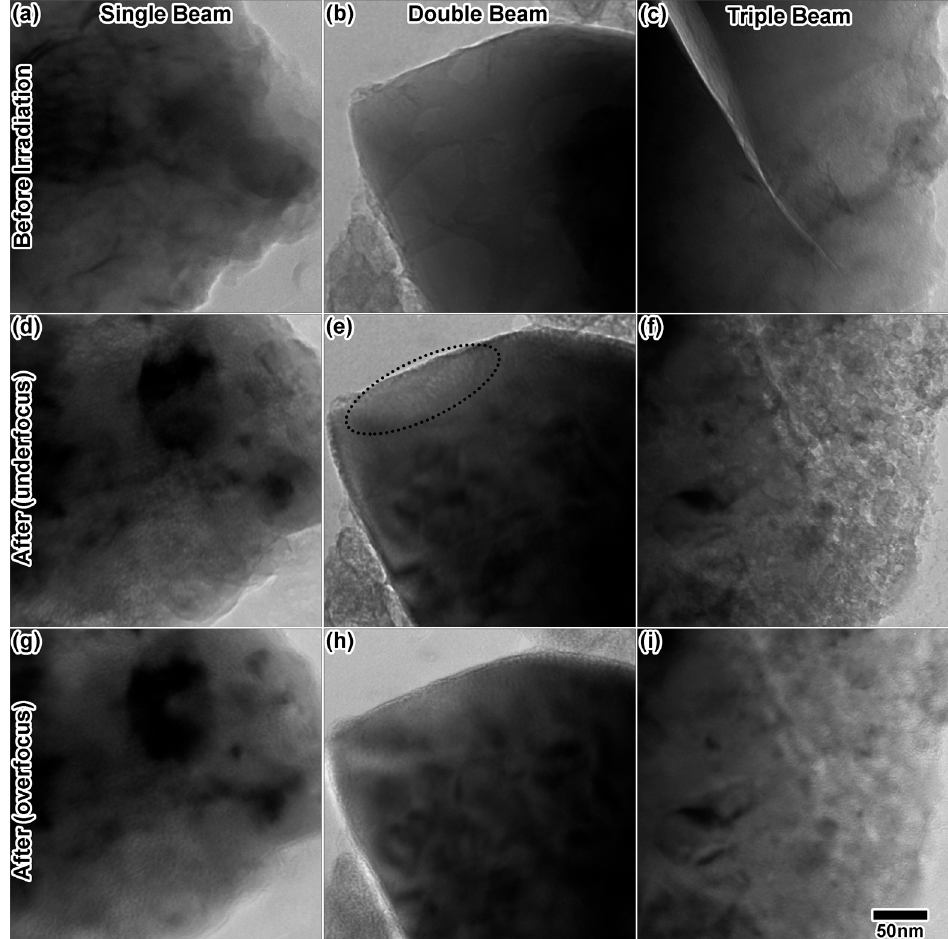
Figure 12. TEM images from before and after single, double and triple ion irradiation at 310 °C in LiAlO 2 . ( a – c ) The particles before irradiation; ( d – f ) The particles in underfocus after irradiation and ( g – i ) the particles in overfocus after irradiation with 10 keV He, 10 keV He + 5 keV D and 10 keV He + 5 keV D + 1.7 MeV Au, respectively. (a,c,d,f) were taken at − 518-nm defocus, and (b,e) were taken at − 1- μ m defocus. (g,i) were taken at +518-nm defocus, and (h) was taken at +1- μ m defocus. The electron beam was on during the single and triple ion irradiations, but off during the majority of the double ion irradiation. The dashed circle in (e) indicates the region where cavities are most visible. All TEM images were taken at the same magnification.